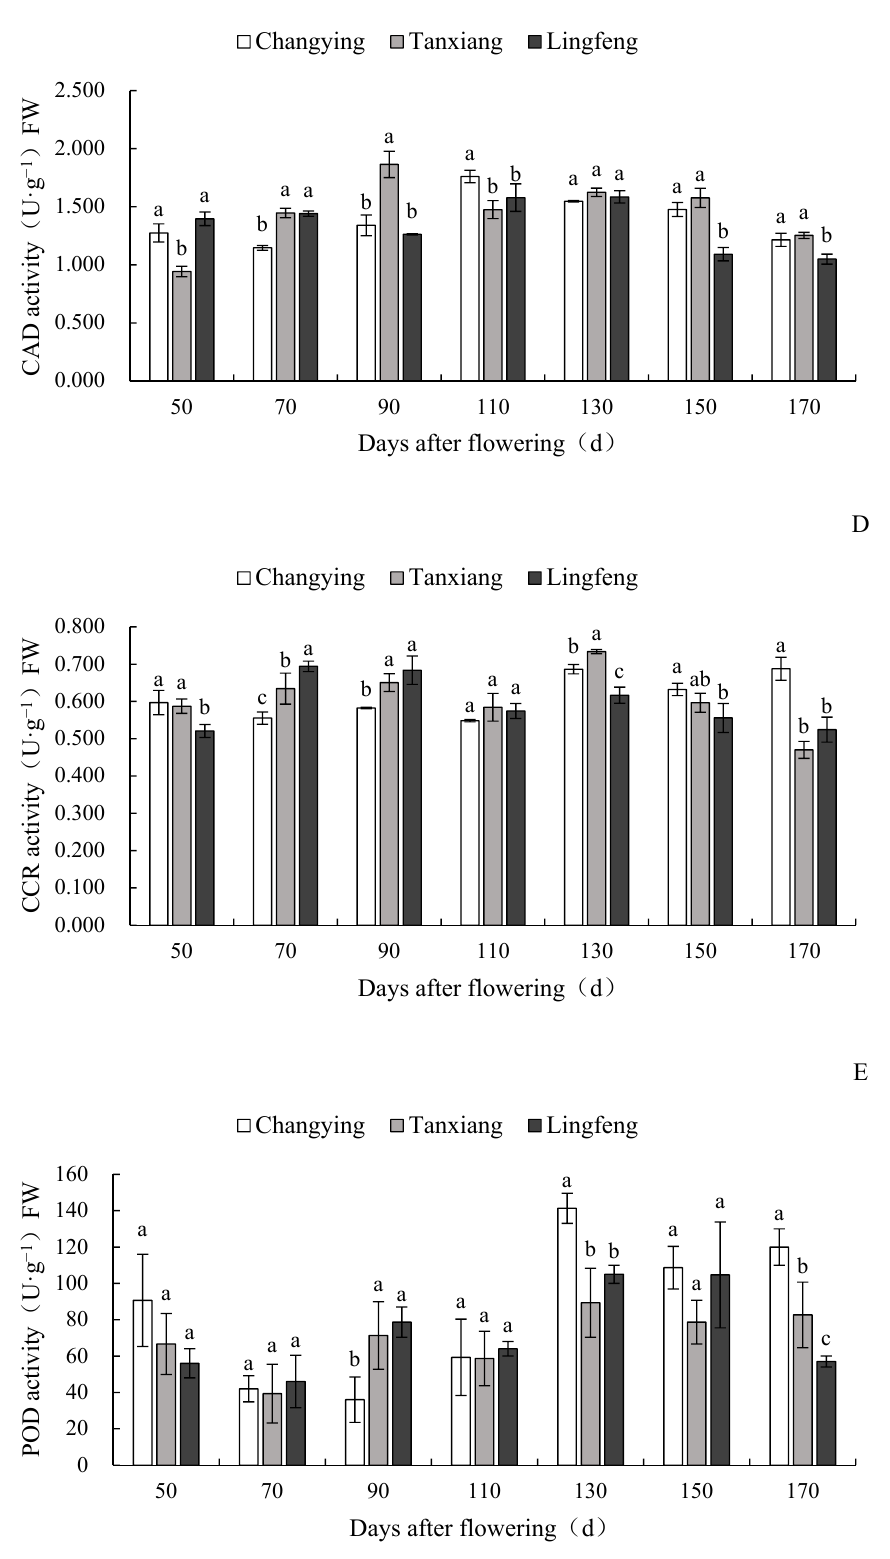
Figure 6. Activities of lignin synthesis enzymes in Chinese olive fruit at different developmental stages. Different letters indicate significant differences between the three varieties within each stage ( p < 0.05). ( A ) PAL, ( B ) 4CL, ( C ) CAD, ( D ) CCR and ( E ) POD.